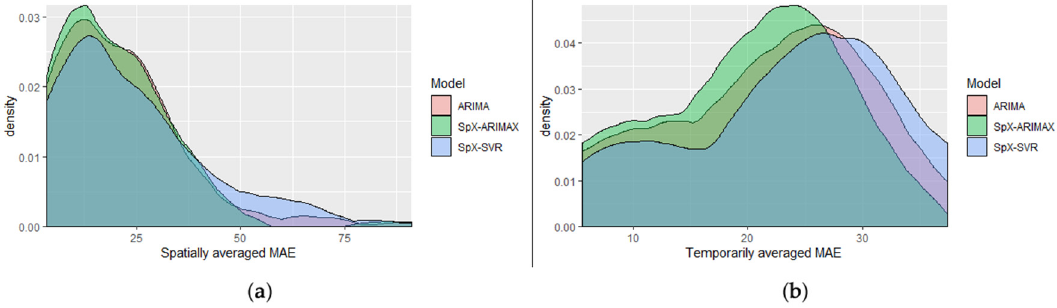
Figure 5. Density of mean absolute error (MAE) values: ( a ) spatially aggregated and ( b ) temporarily aggregated.